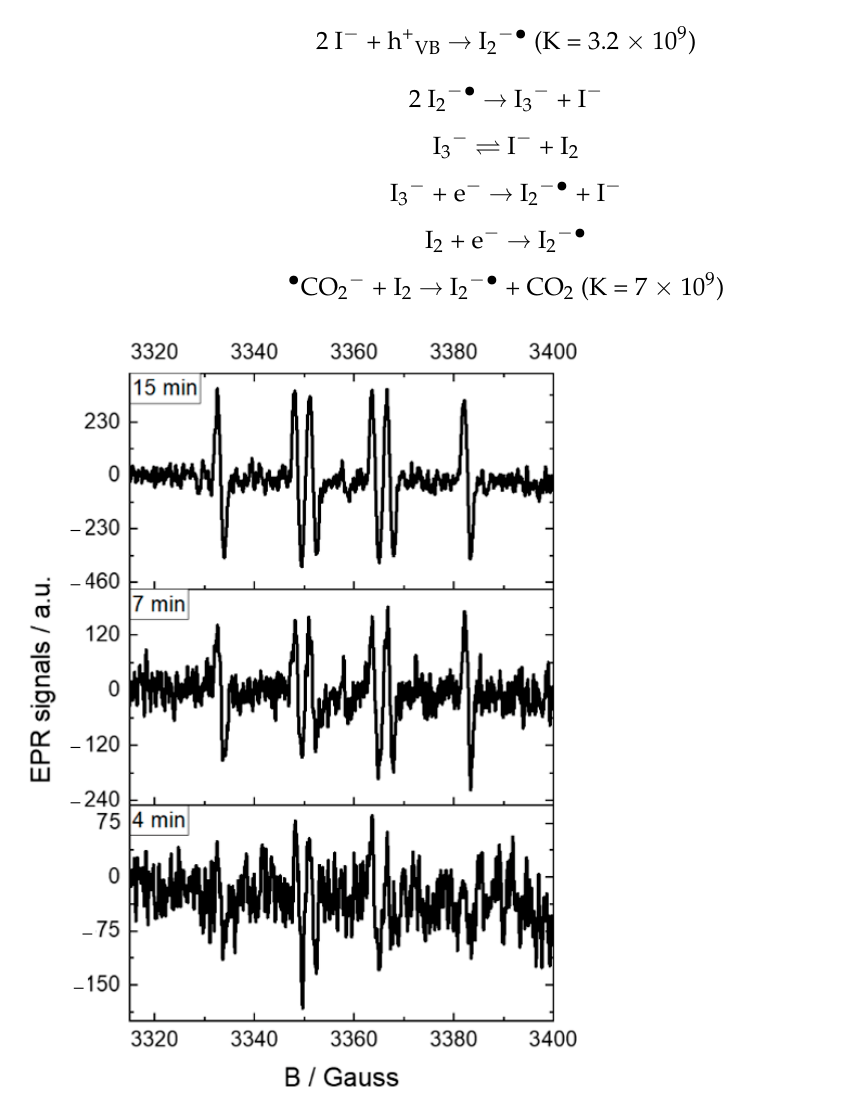
Figure 6. EPR spin trap experiments in N 2 atmosphere for a UV-irradiated suspension